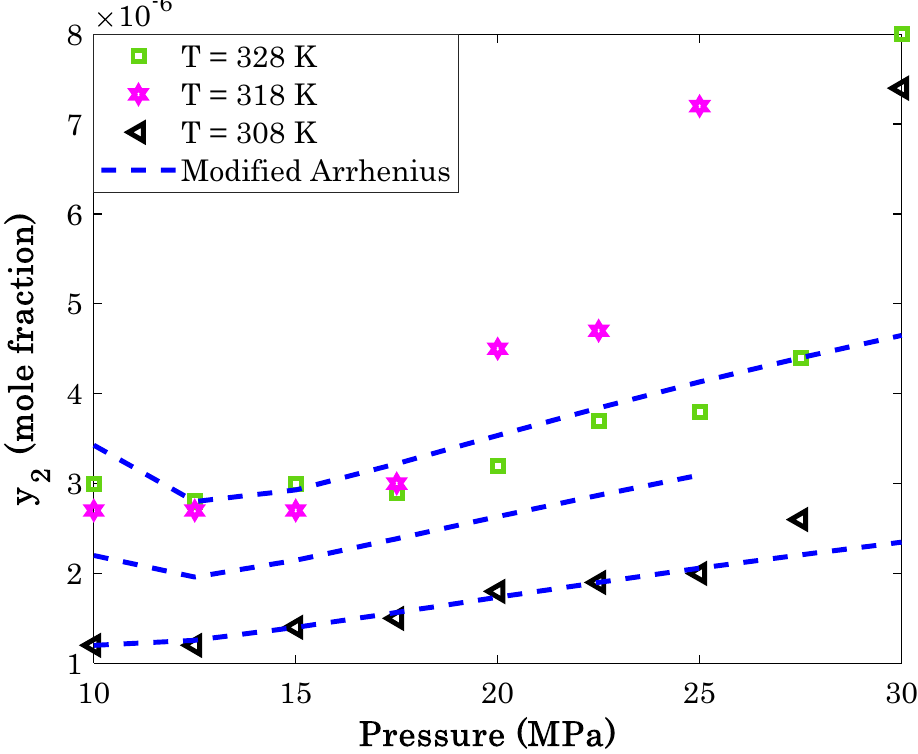
Figure 12. The effect of pressure and temperature on the thymidine solubility in the supercritical carbon dioxide.